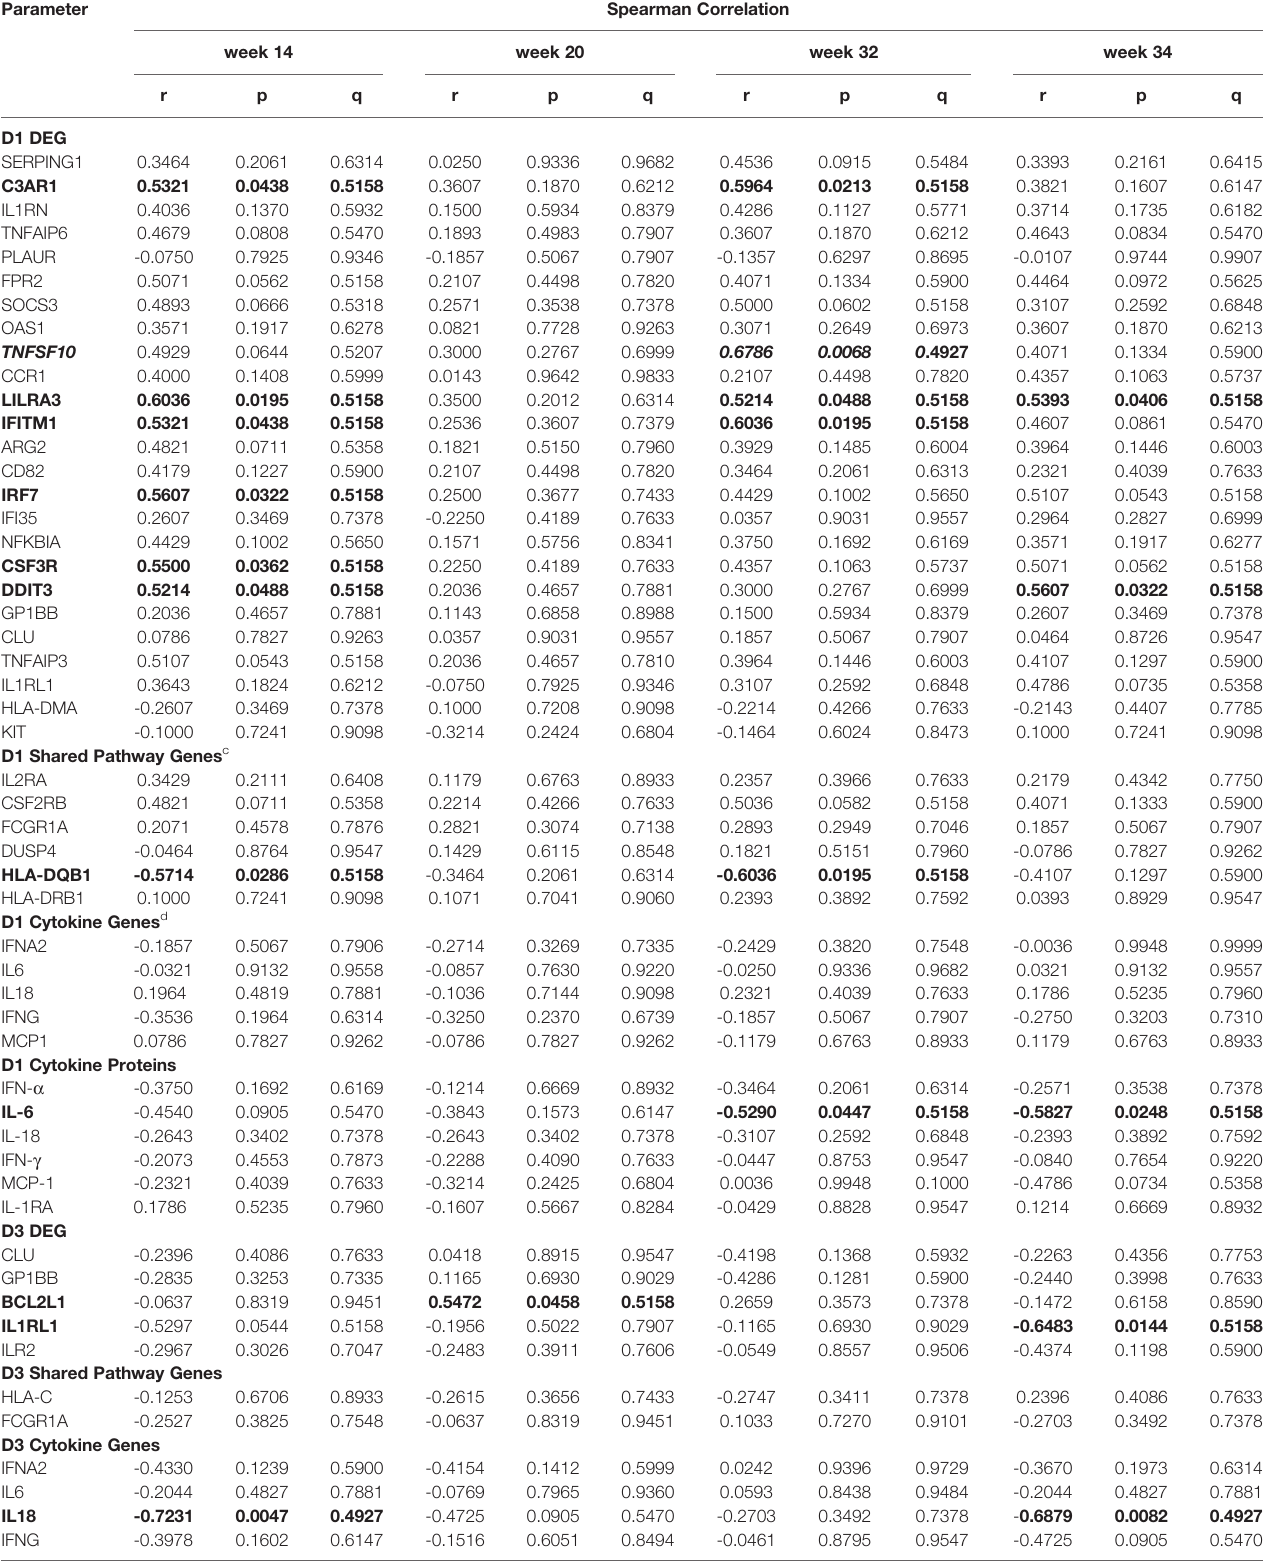
TABLE 2 | Correlation of early gene expression with vaccine-induced Env-speci fi c